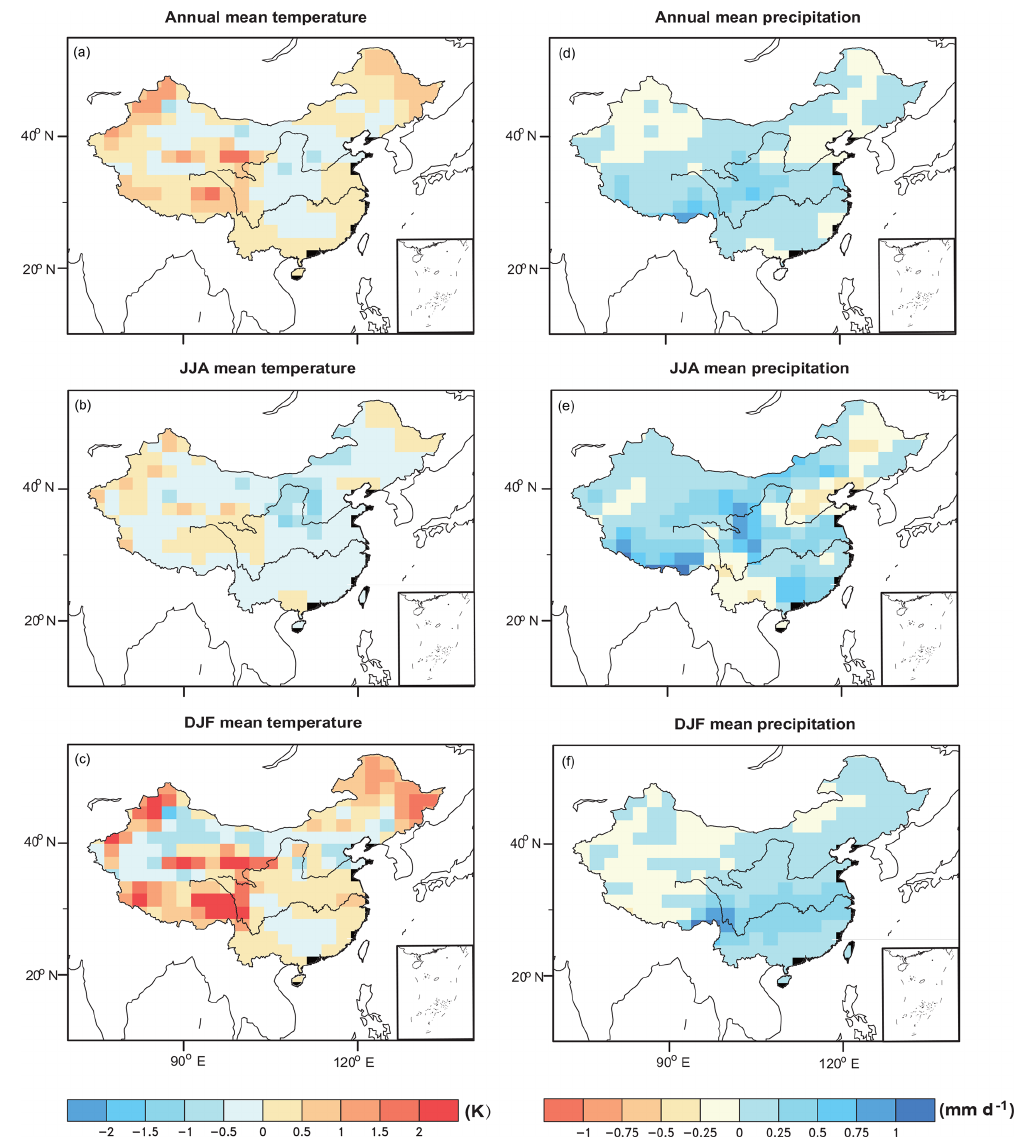
Figure 11. Climate anomalies between the two experiments (6ka and 6ka_VEG) conducted in CESM version 1.0.5. The anomalies (6ka_VEG-6ka) of temperature and precipitation at both the annual and seasonal scale are presented, and all these climate variables are calculated as the last 50-year means from two